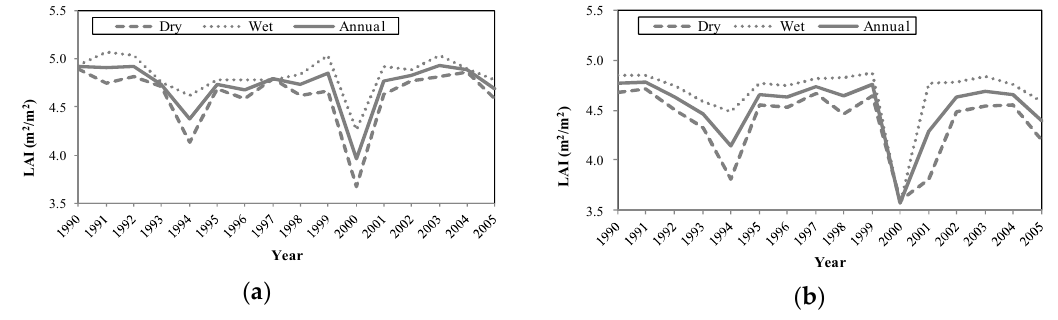
Figure 4. Annual and seasonal LAI in the ( a ) No.1 experimental watershed and ( b ) Jianfengling National Forest Park from 1990 to 2005.